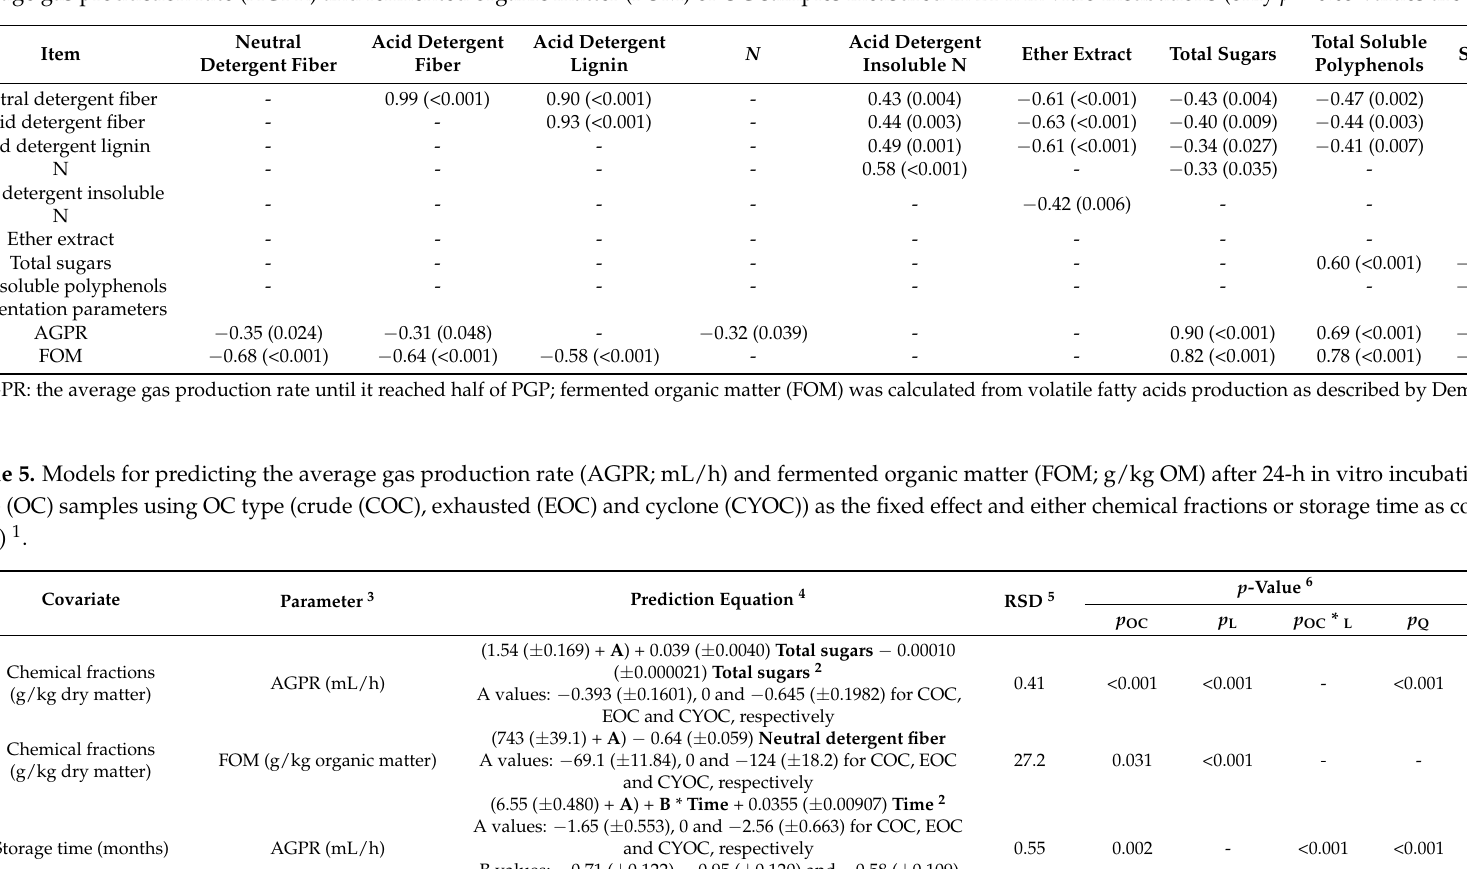
Table 4. Correlation matrix (Pearson coefficient and p values in brackets; n = 42) of the chemical composition of olive cake (OC) samples and storage time with the